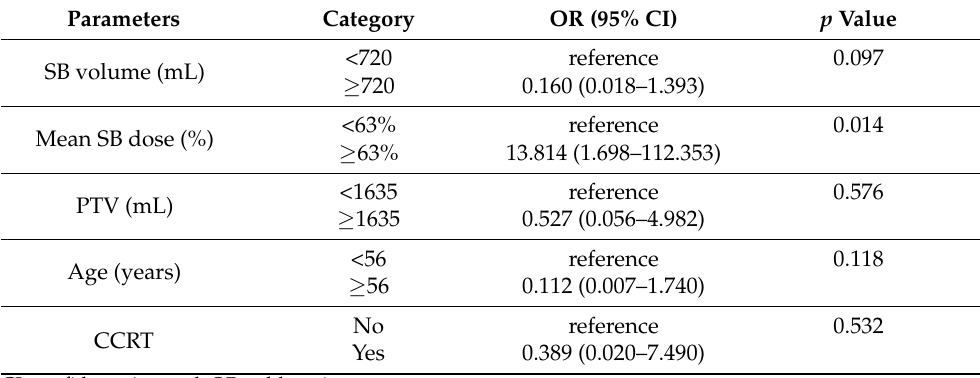
Table 4. Multivariate analyses of early-onset